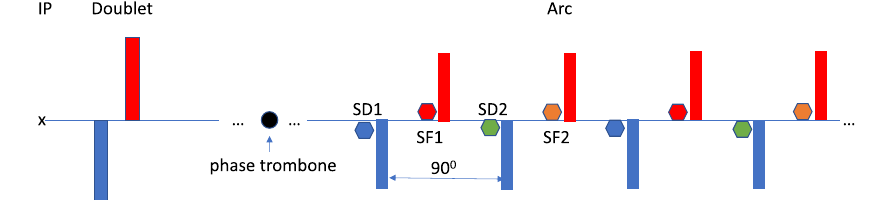
FIG. 5. Scheme of chromatic compensation on one side of low-beta IR using the four sextupole families in the adjacent arc where the vertical bars are quadrupoles and the hexagons are